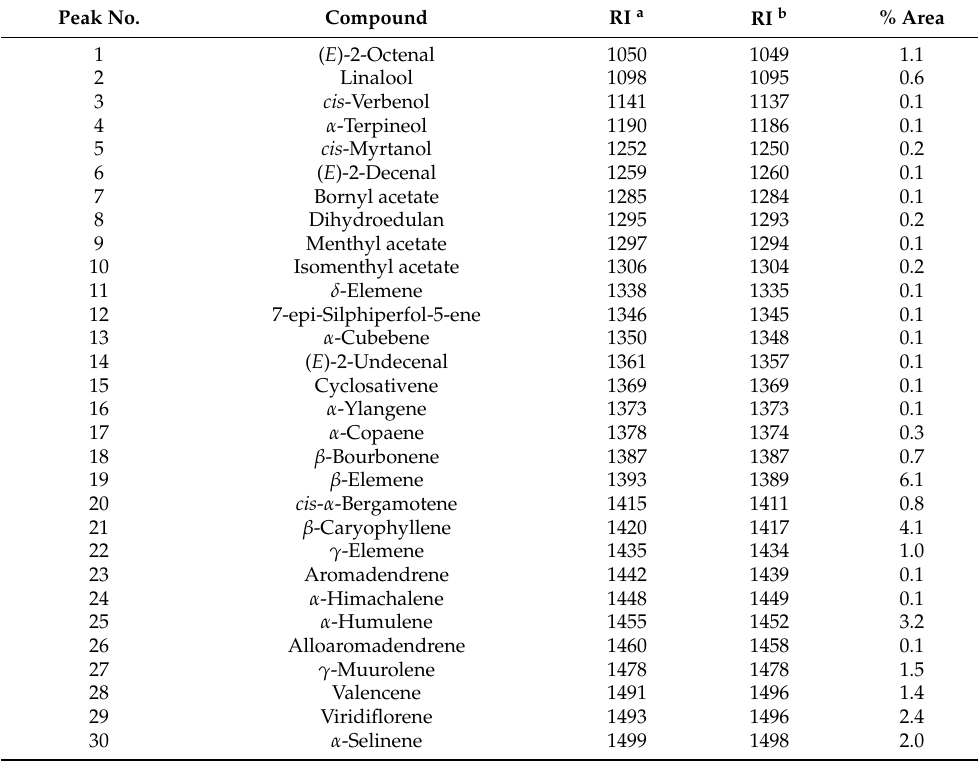
Table 1. Chemical composition of M. nepalensis essential oil. Peak